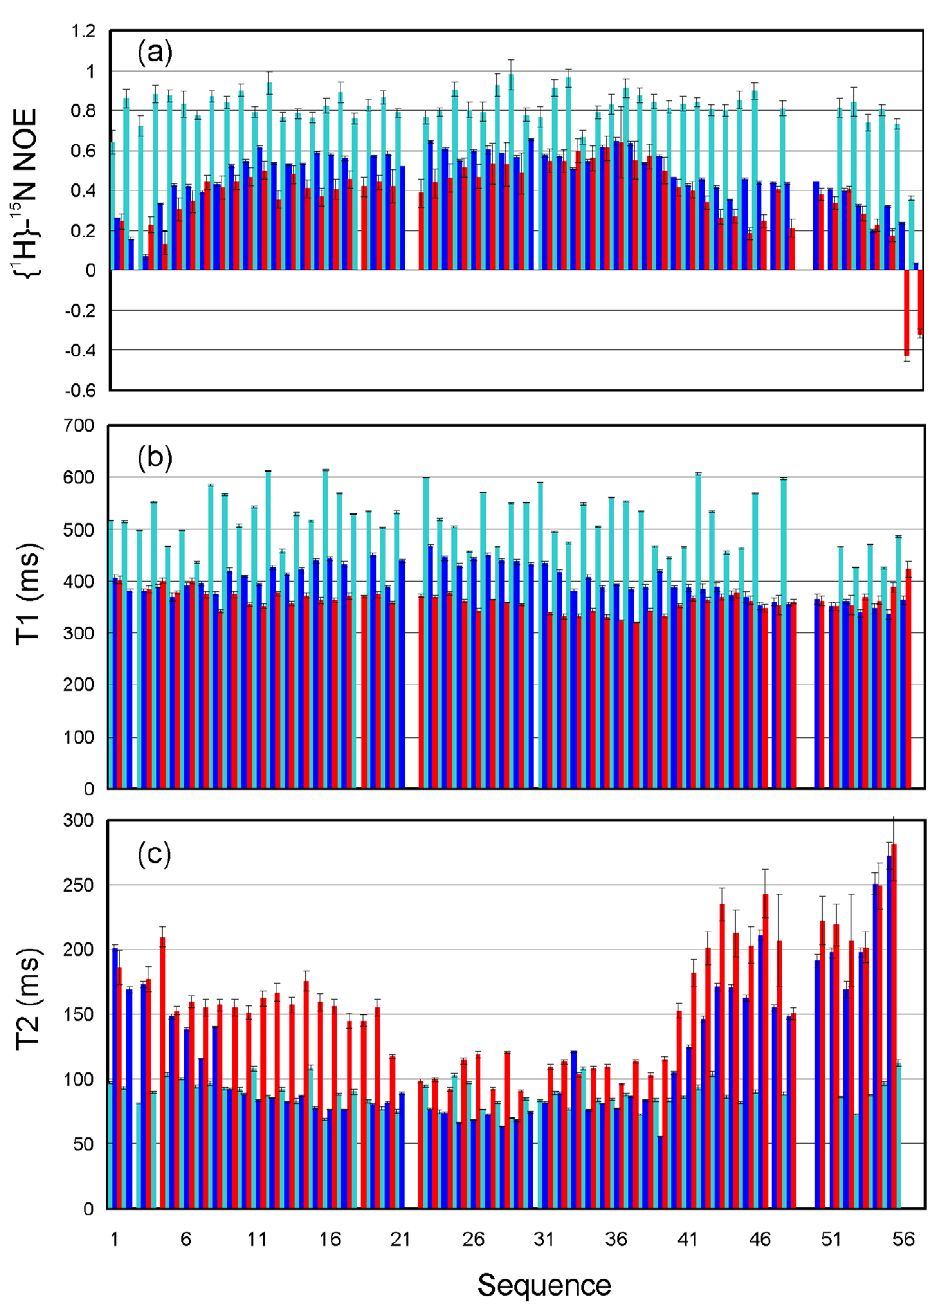
Figure 8. 15 N NMR backbone relaxation data. The 15 N NMR backbone relaxation data of V22-SH3 solubilized in salt-free water at pH 4.0 (red); wild-type at pH 6.5 (cyan); and wild-type at pH 2.0 (blue) as measured at 800 MHz. (a). { 1 H}- 15 N steady-state NOE intensities. (b). 15 N T1 (longitudinal) relaxation times. (c) 15 N T2 (transverse) relaxation times.